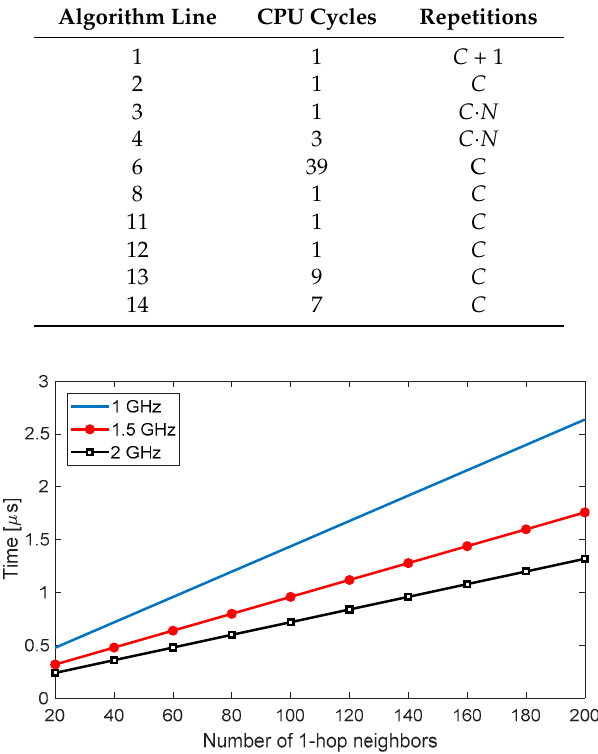
Figure 11. Upper bound of the CPU time needed to execute COMPASS for 3 CPU speeds, C = 3